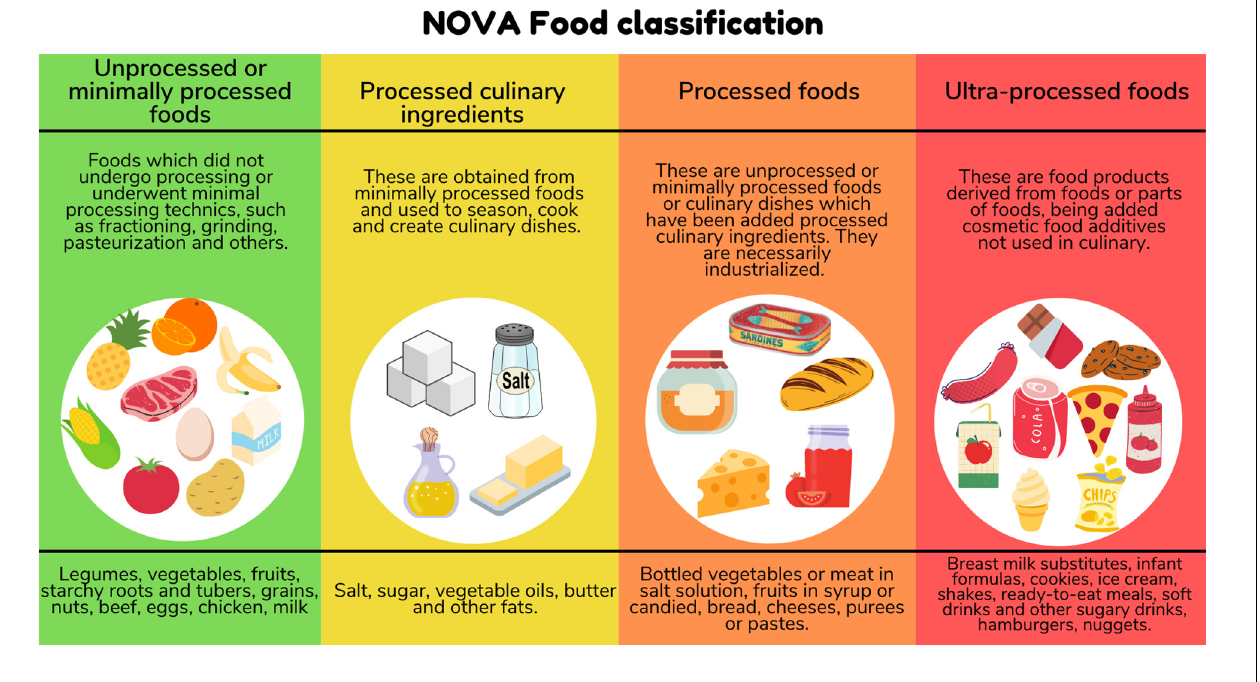
FIGURE 1 | NOVA food